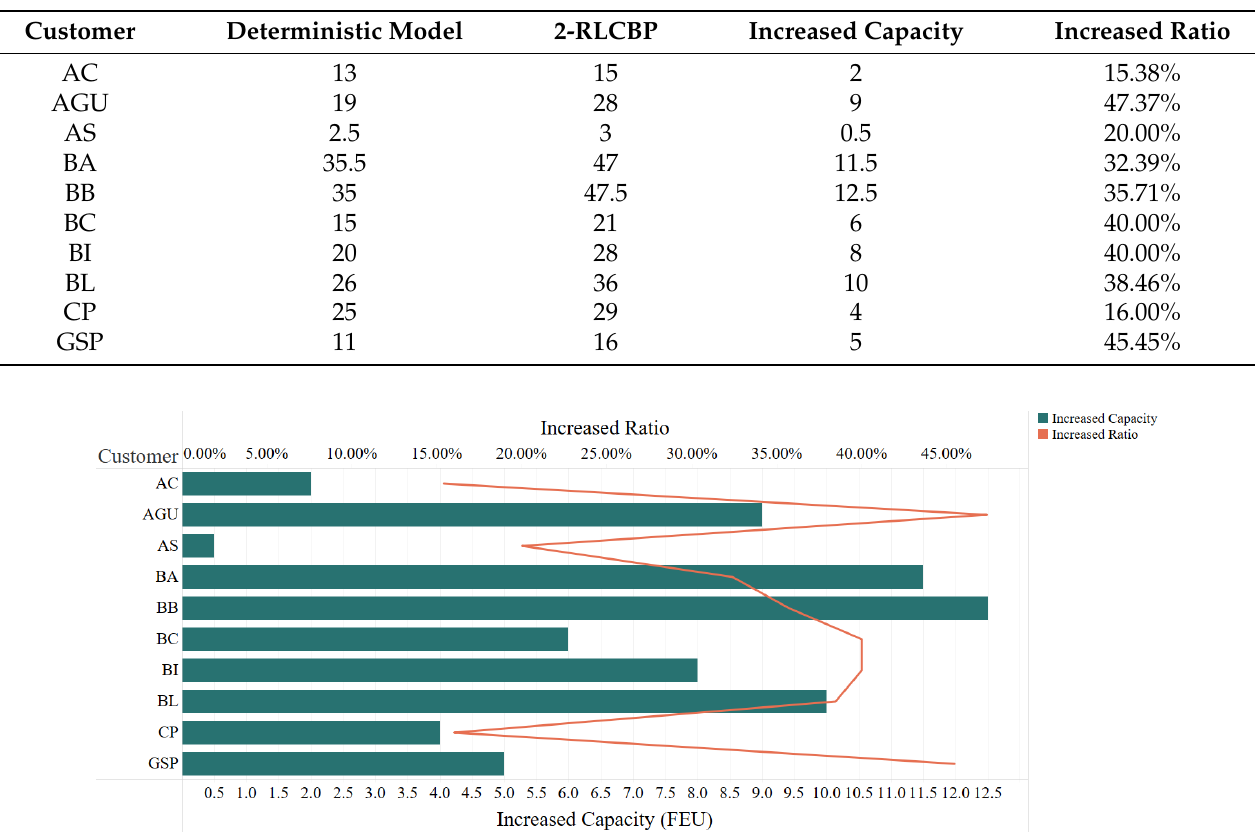
Figure 6. Increase in transportation capacity booked for each customer in 2-RLCBP comparing to deterministic